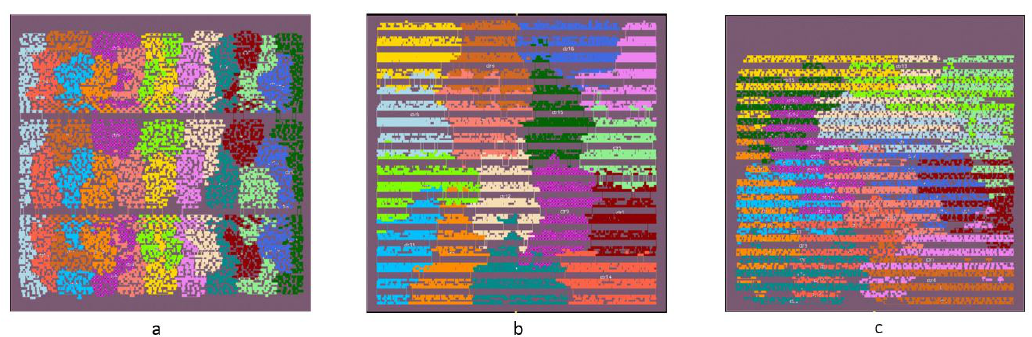
Figure 5. Amouba view of the investigated design. Each triplicated counter has a different color to highlight the placement strategy. ( a ) 3Blocks ( b ) Interleaved ( c ) Improved